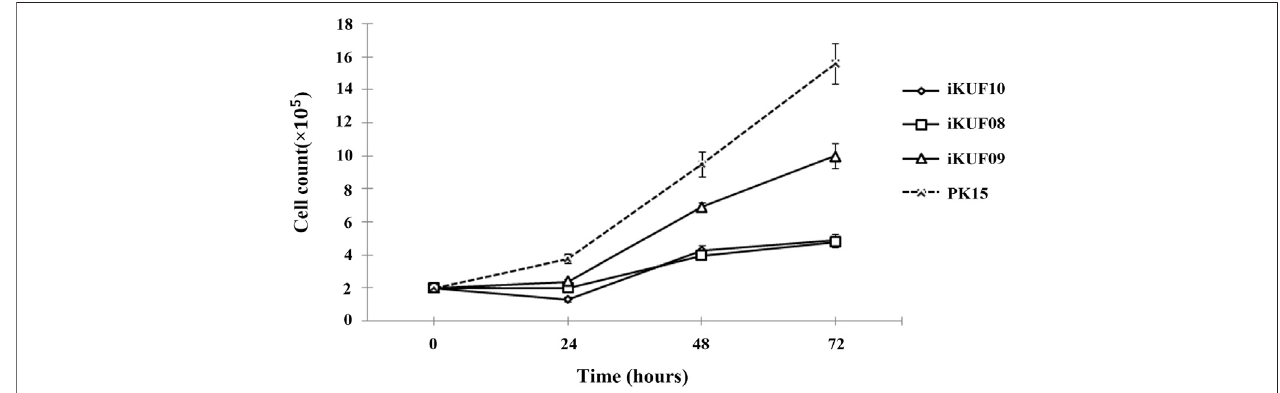
FIGURE 2 | Growth curves of immortalized fi broblast cells. Three randomly selected cell lines, iKUF08, iKUF09, and iKUF10, and a commercially available PK15 were used. The culture duration is indicated on the x-axis.